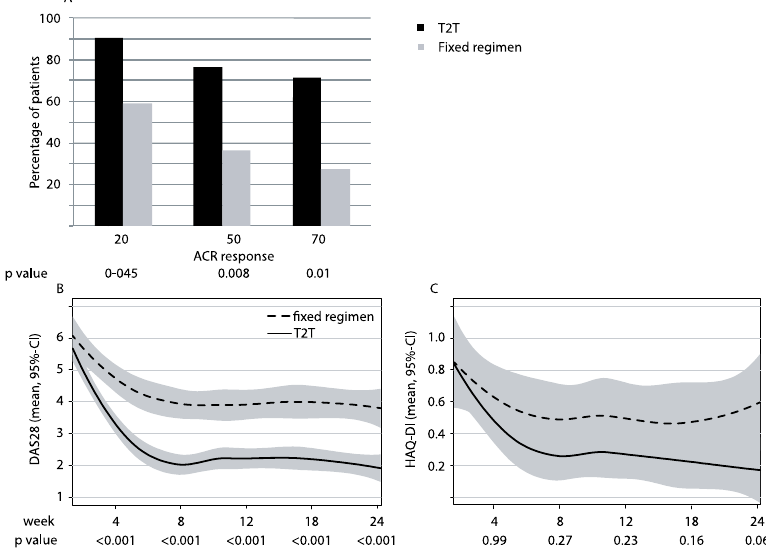
Figure 3. Response to treatment: ( A ) Percentage of patients achieving an ACR 20/50/70 response was